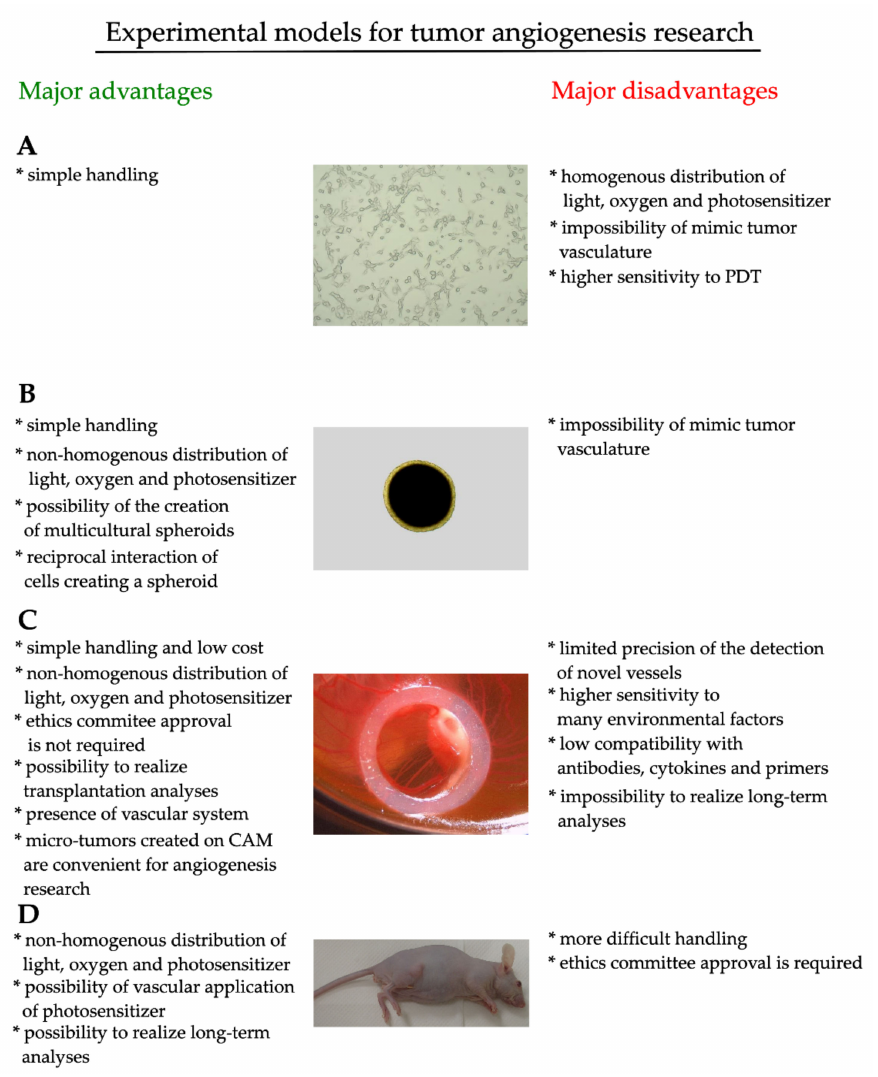
Figure 1. Major advantages and disadvantages of convenient experimental models for tumor angiogenesis research utilized. Picture ( A ) represents the 2D experimental model, ( B ) represents the 3D experimental model known as a spheroid, ( C ) represents the micro-tumor created on the quail ( Coturnix japonica ) avian embryo, and ( D ) represents the tumor-bearing